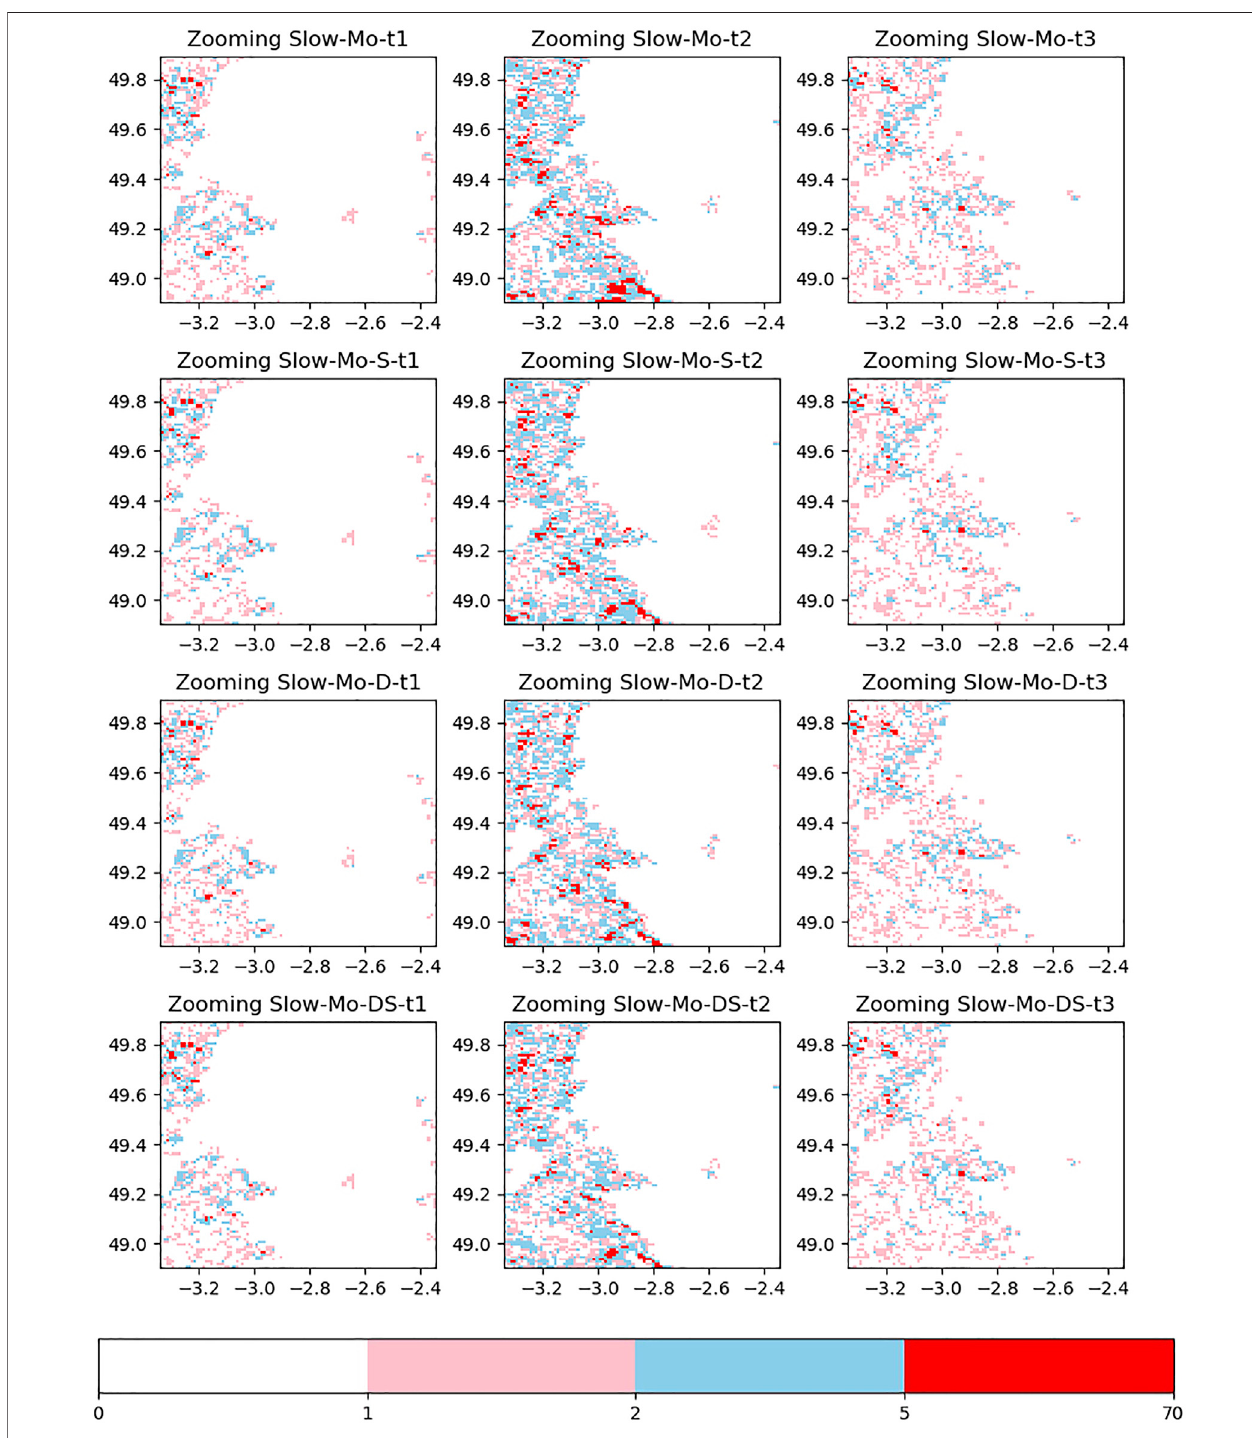
FIGURE 12 | Image of the difference between the prediction and the real